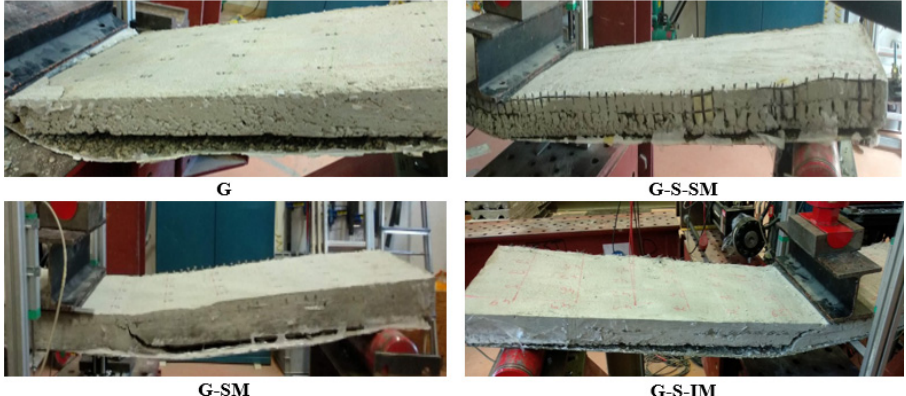
Figure 5. The failure mode of debonding for all specimen types.